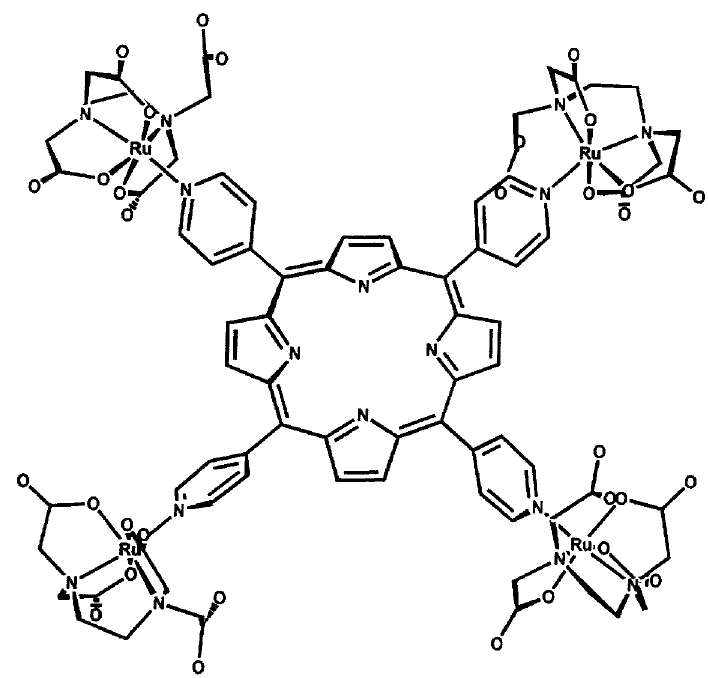
Fig. 6 – Structural representation of the polymetallic porphyrin [MTPyP{Ru(edta) 4 ] n +